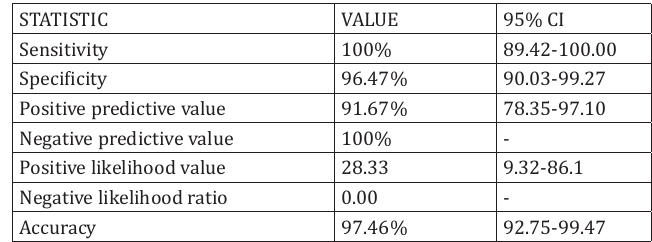
Diagnostic accuracy of raised ONSD measurement in prediction of elevated